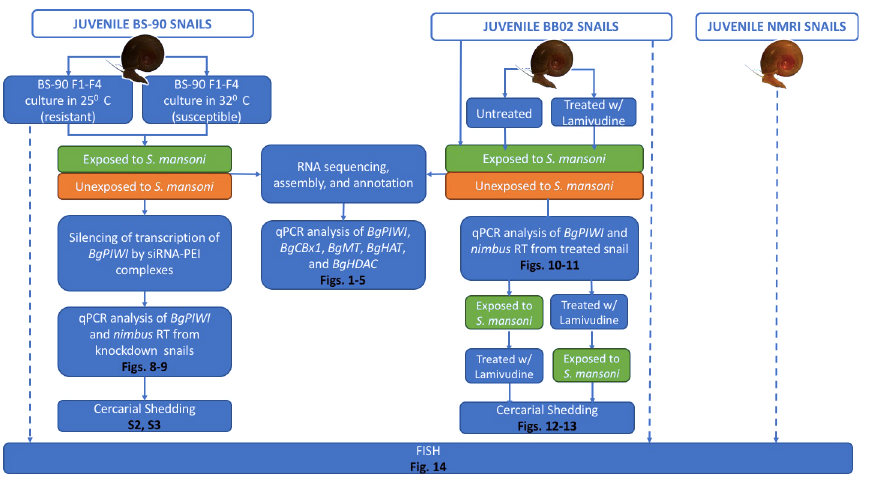
Fig 6. Graphical flow chart illustration of the results and experimental design. Juvenile snails were used in the study and were exposed to S . mansoni miracidia as described on MATERIALS and METHODS.